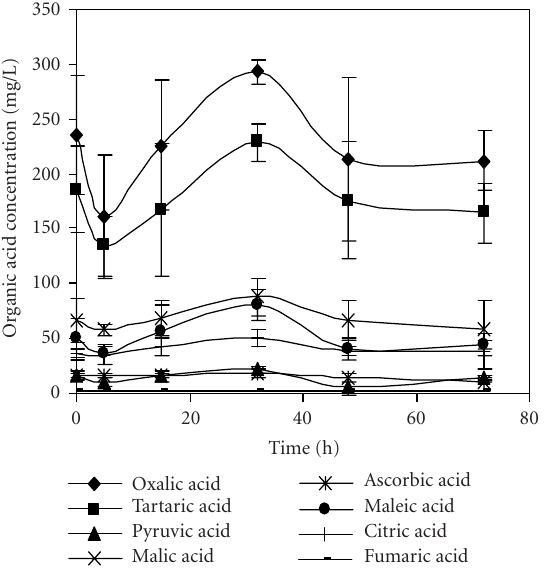
Figure 3. Evolution of concentration of organic acids present in the pomegranate juice obtained by seed centrifugation and stored for 72 hours at 4 ◦ C. Bars represent standard deviation of 4 replications.